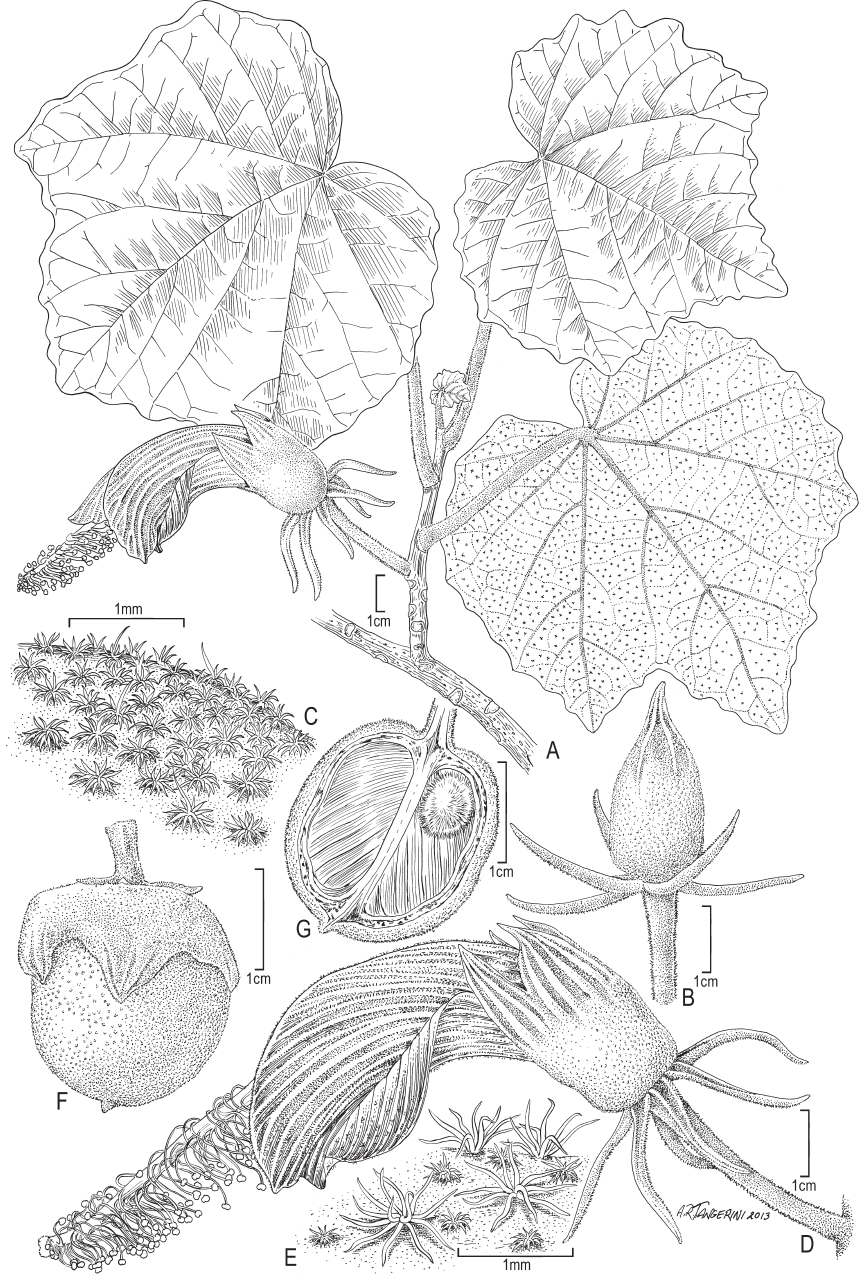
Figure 2. Hibiscadelphus stellatus H. Oppenh., Bustamente, & Perlman. A Habit B Flower bud C Sur- face of calyx showing stellate hairs D Flower E Surface of corolla showing two sizes of stellate hairs F Fruit G Longitudinal section of fruit showing seed. Drawn from Oppenheimer et al. H41337 (US) and field photographs by the